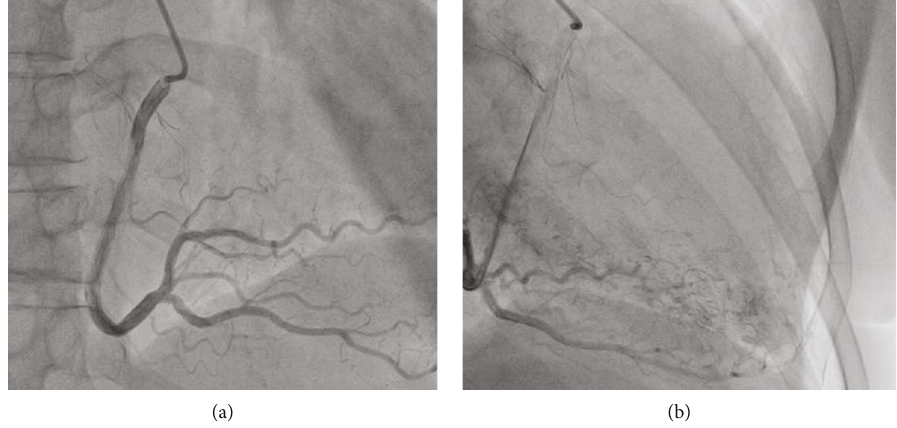
Figure 3: (a) Right coronary artery. (b) Multiple micro fi stulas draining in the left